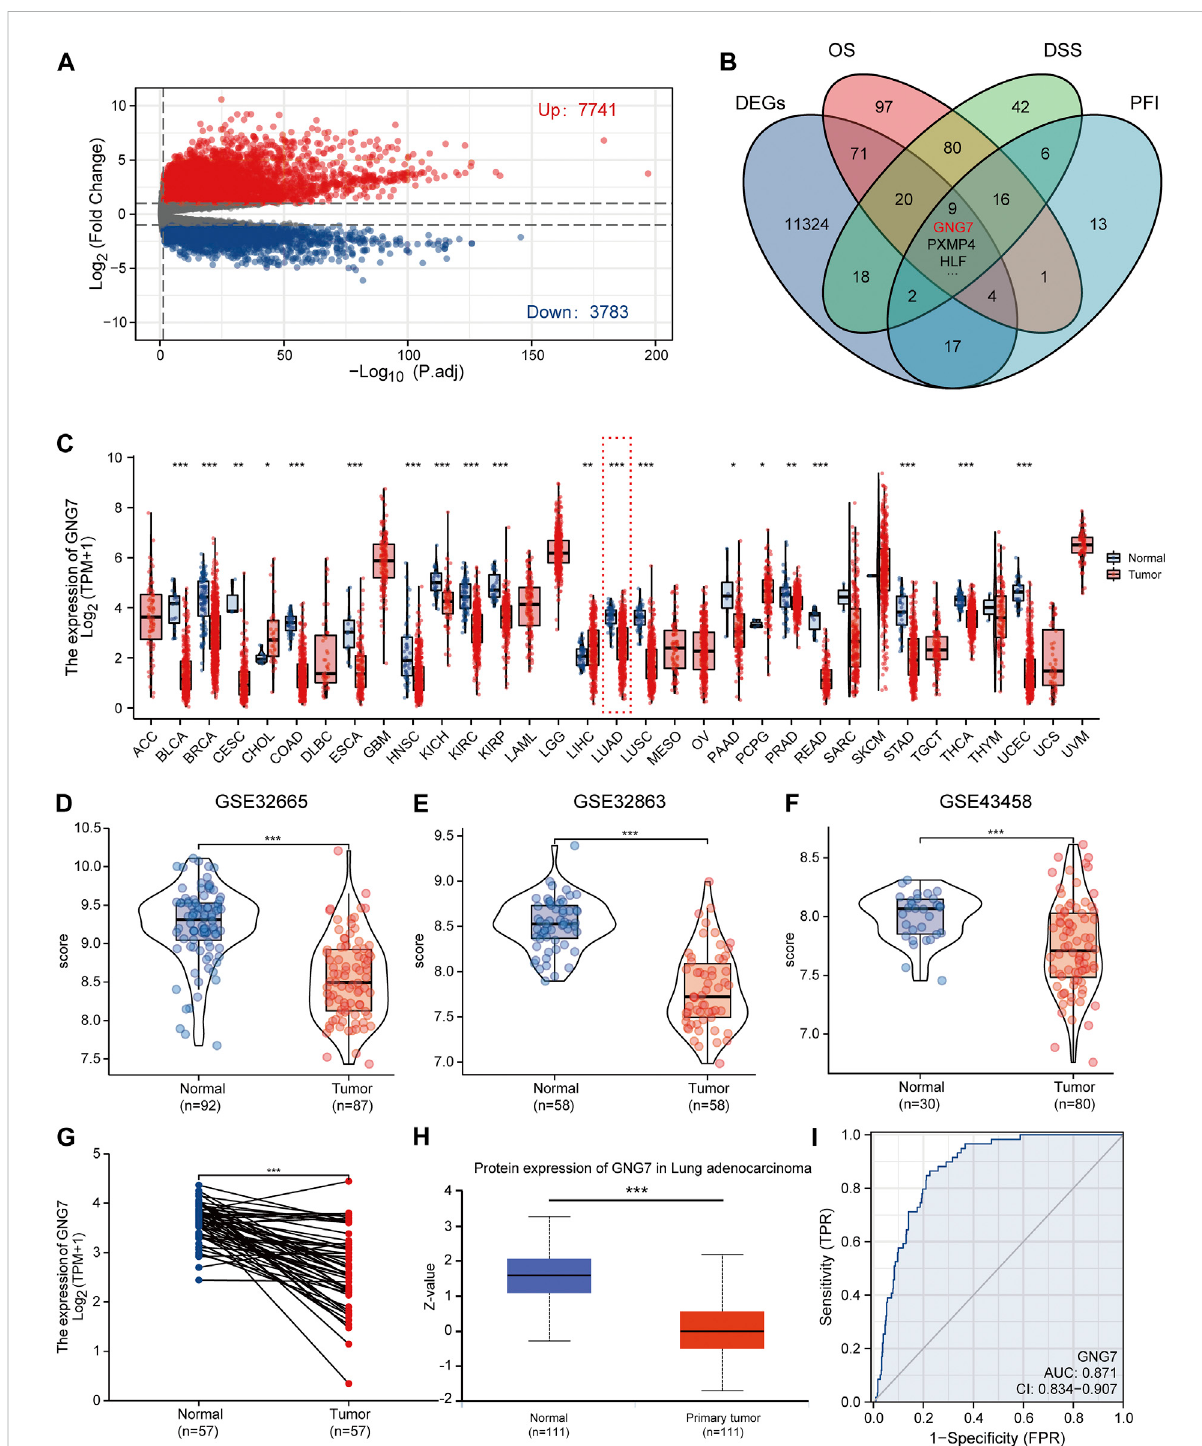
FIGURE 2 Screening of key regulators and identi fi cation of the differential expression of GNG7 in LUAD. (A) The volcanic map of the DEGs in LUAD. (B) A Venn diagram used to identify nine DEGs associated with LUAD prognostic indicators. (C) The GNG7 expression in different cancer from the TCGA database. (D – F) TheGNG7mRNAexpression betweenLUADand normal tissues basedon data fromGSE32665 (D) ,GSE32863 (E) and GSE43458 (F) dataset. (G) The GNG7 mRNA expression between paired LUAD tumor tissues and adjacent normal tissues from the TCGA-LUAD dataset. (H) The GNG7 protein expression between LUAD and normal tissues from the UALCAN database. (I) A ROC curve to test the ef fi ciency of GNG7 to identify LUAD from normal lung tissue. * p < 0.05, ** p < 0.01, *** p <